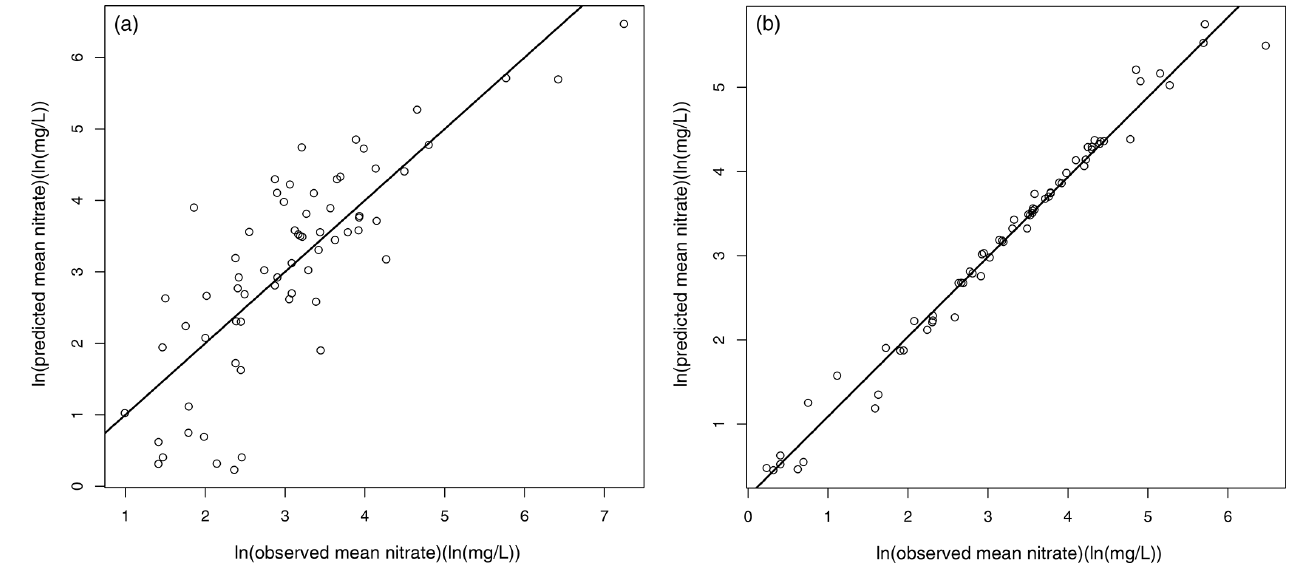
Figure 2. Comparison of observed and predicted log (ln) nitrate concentration on training dataset: (a) Linear regression and (b) Random Forest Regression.